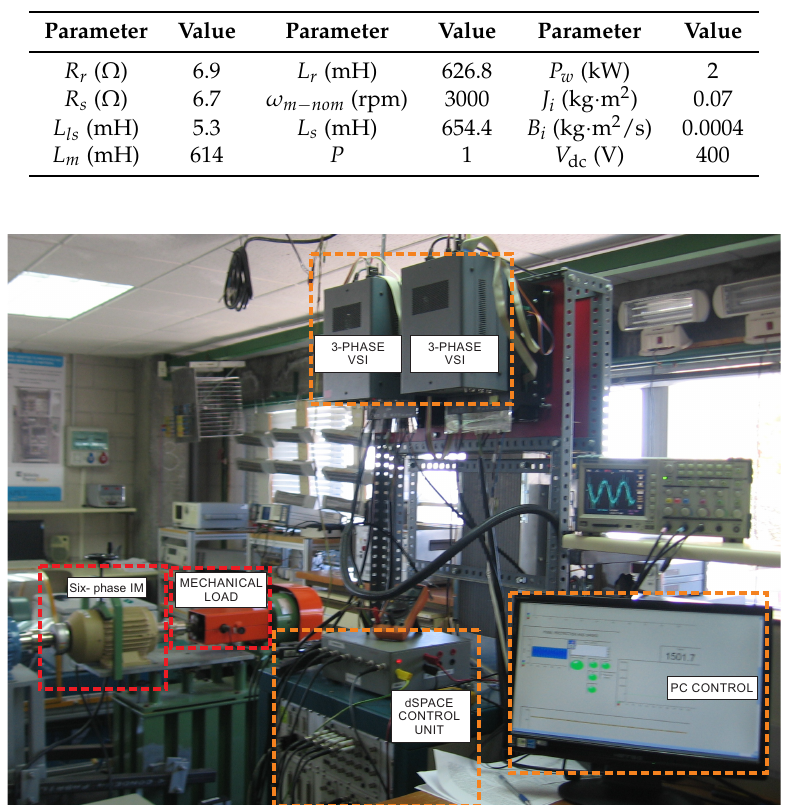
Figure 3. Block diagram of the test bench including the six-phase IM, the six-leg VSI, the dSPACE and the mechanical